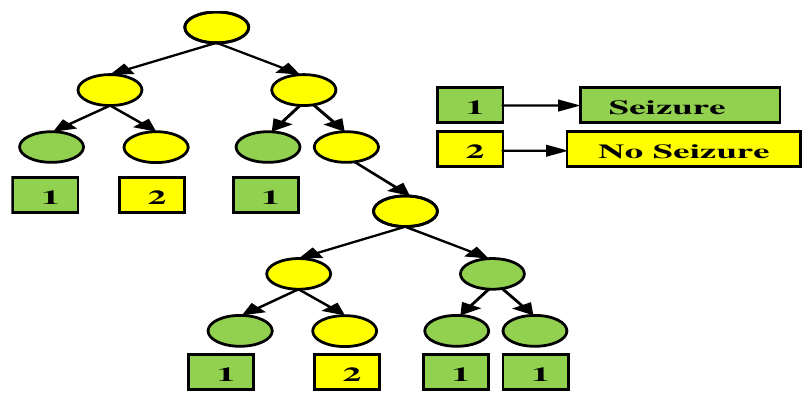
Figure 6. The architecture of the random forest classifier.